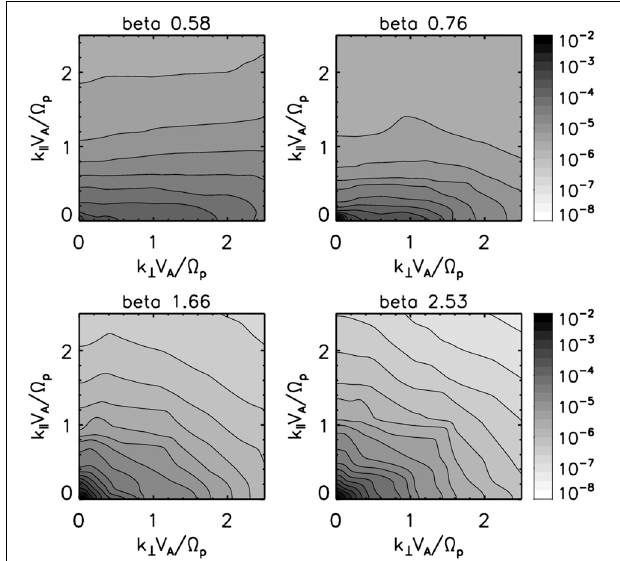
FIGURE 2 | Energy spectra of magnetic field fluctuations in the solar wind in the reduced two-dimensional wave vector domain spanned by the parallel and perpendicular components of the wave vector to the large-scale magnetic